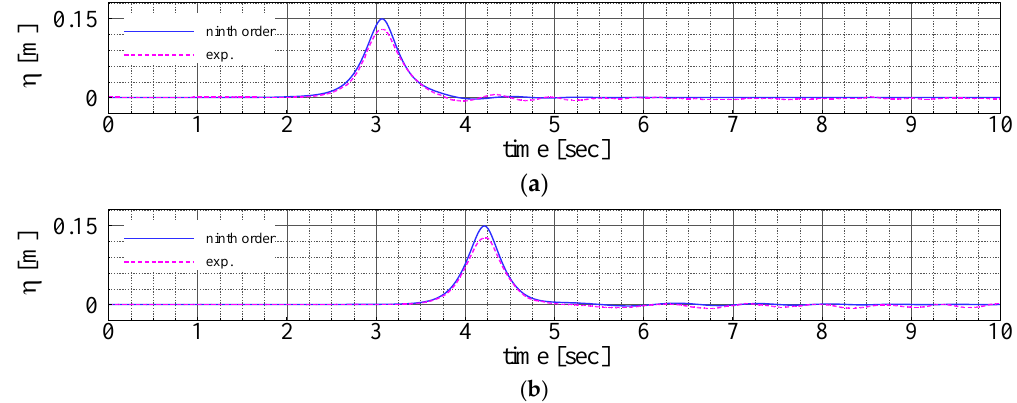
Figure 8. Validation of the water surface evaluation based on the ninth-order solution. ( a ) x = 1.55 m; ( b ) x = 3.95 m.